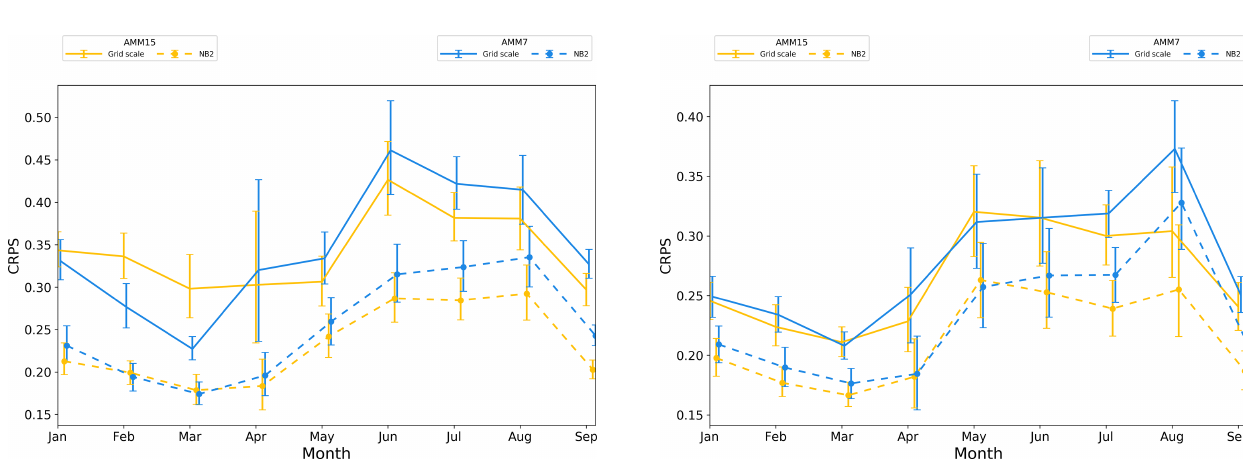
Figure 14. Off-shelf monthly time series of CRPS. Error bars rep- resent 95% confidence values obtained from 10000 samples using bootstrap with replacement.